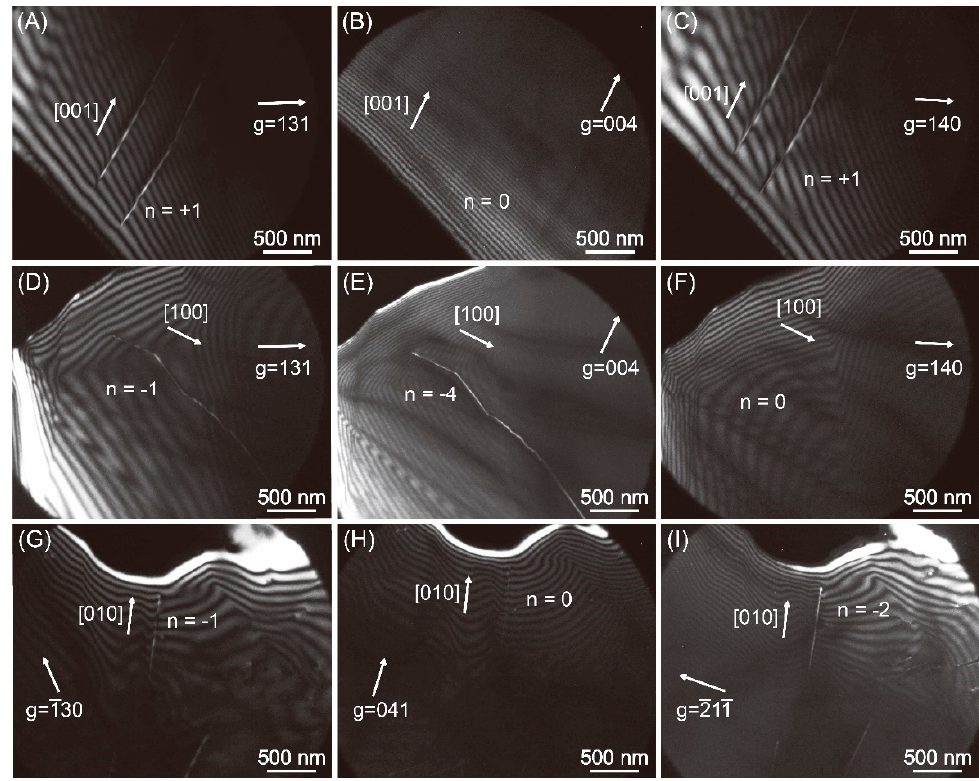
Figure 7. Representative weak-beam dark-field images showing the dislocation microstructure of olivine in three different locations from sample 448. The diffraction vectors for each image are de- noted as g . The white arrow and n value indicate the number of the terminating thickness fringes for each image. ( A – C ) WBDF images of the same location with different three diffraction vectors: g = 131 in ( A ), g = 004 in ( B ), and g = 140 in ( C ). ( D – F ) WBDF images of a second location/site with three different diffraction vectors: g = 131 in ( D ), g = 004 in ( E ), and g = 140 in ( F ). ( G – I ) WBDF images of a third location / site with three different diffraction vectors: g = 1´ 30 in ( G ), g = 041 in ( H ), and g = 2´ 1 1´ in ( I ).